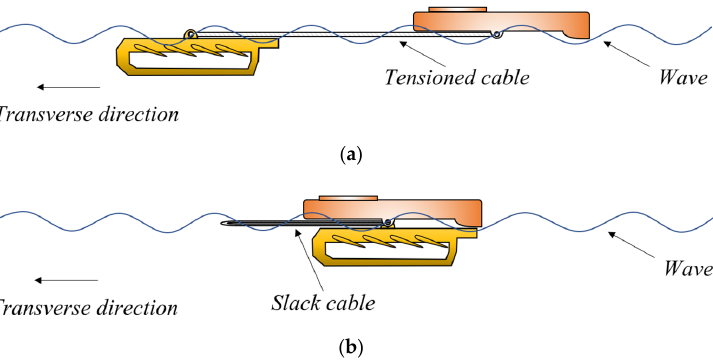
Figure 4. Deployment method of wave glider ( a ) Method 1, ( b ) Method 2.